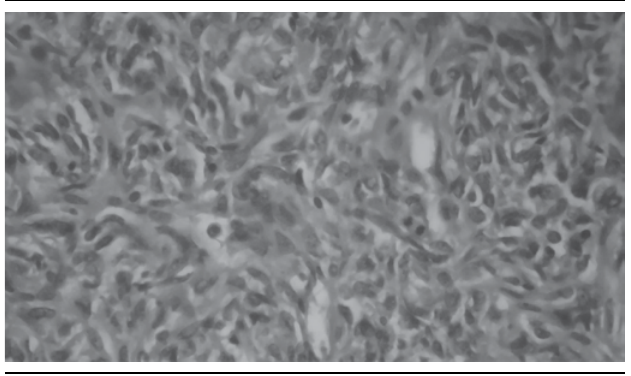
figurE 3 – Sections studied in routine staining (H&E) showed loss of cytological architecture with stromal and perivascular hyalinization pattern. Collagen deposition can frequently be observed H&E: hematoxylin and